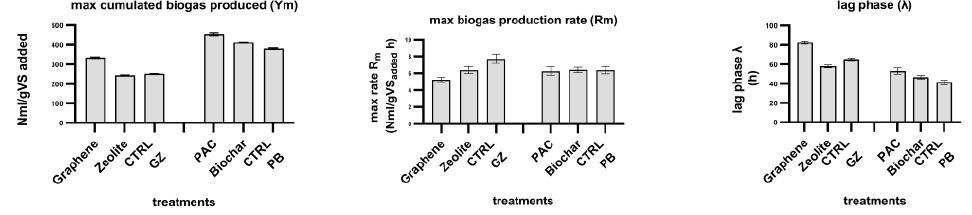
Figure 3. Comparison of the kinetic parameters obtained by the Gompertz fitting. From the left to the right: maximum cumulative biogas production (Ym), maximum production rate and lag phase. CTRL-PB is referred to as the control for the PAC and biochar added tests, CTRL-GZ as the control for graphene and zeolite added reactors.